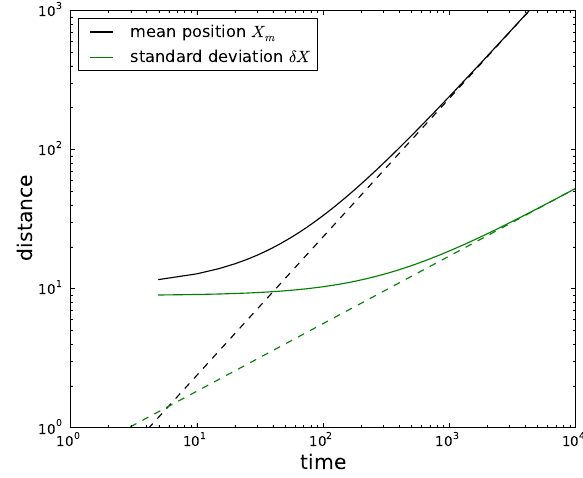
Fig. 3. Mean position X m (black line) and standard deviation δX (green line) of a plume of tracers as a function of time for α = 0 . 3. Dashed lines show the power laws expected for standard advection- diffusion: linear (black) and square root (green).